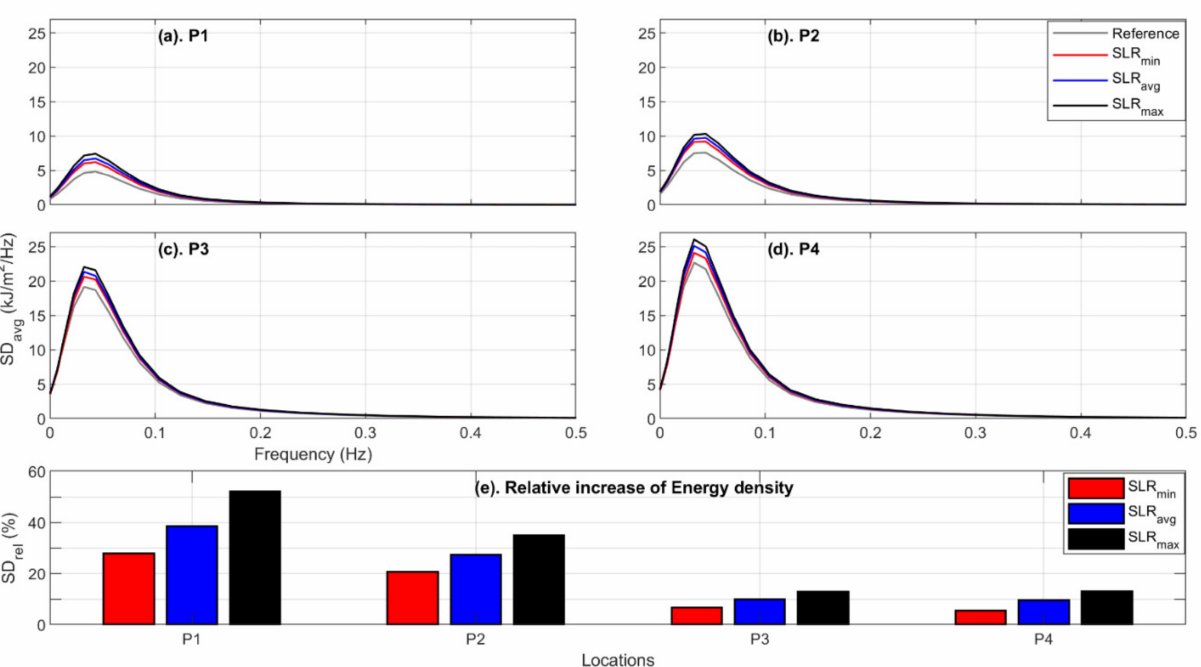
Figure 9. Average wave energy density spectrum ( SD avg : Equation (2)) during the analysis period from 7 January– 18 February 2013 for the reference (gray line), SLR min (red), SLR avg (blue), and SLR max (black) scenarios at P1: 0 m depth ( a ), P2: 2 m depth ( b ), P3: 4 m depth ( c ), and P4: 6.5 m depth ( d ) in the G3 domain (see Figure 8). ( e ) Relative increases in the wave energy density spectra with respect to the reference scenario ( SD rel : Equation